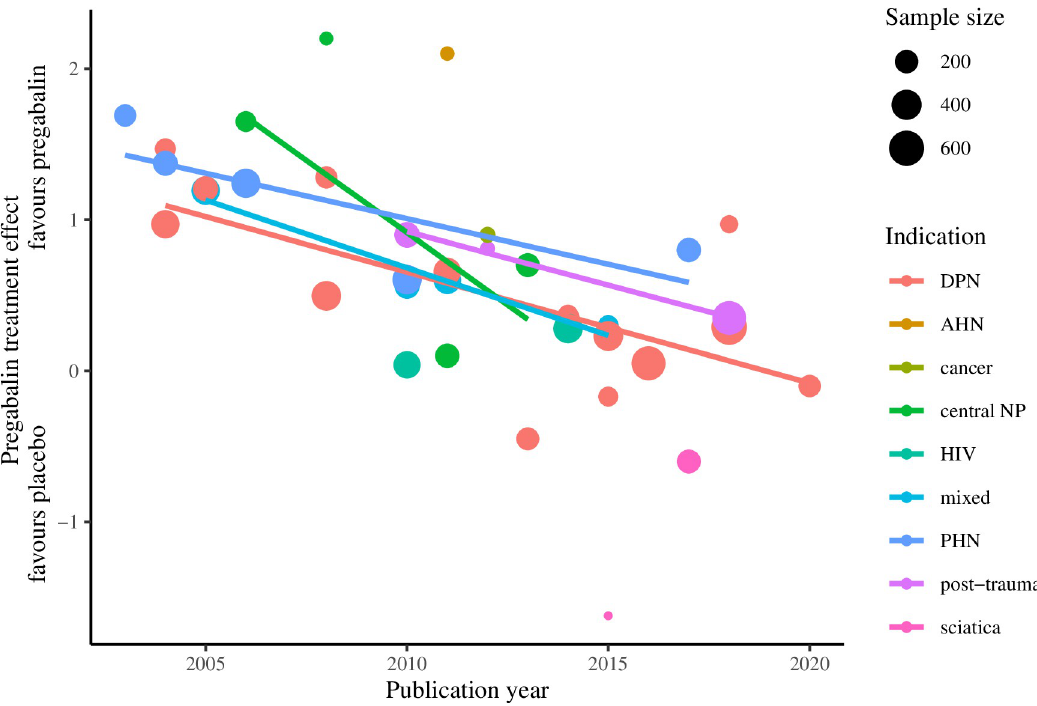
Fig 5. Treatment effect of pregabalin over publication year � by indication. � Derived from unadjusted meta-regression models. Subgroups with two or fewer studies were not evaluated.